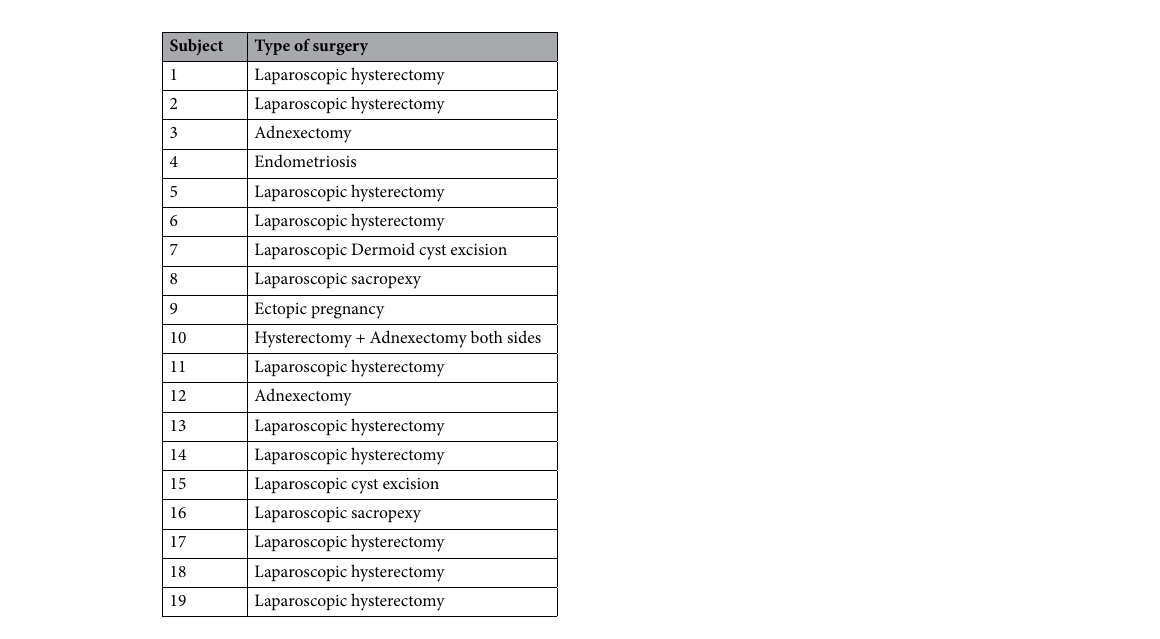
Table 7. Type of surgical procedure for all